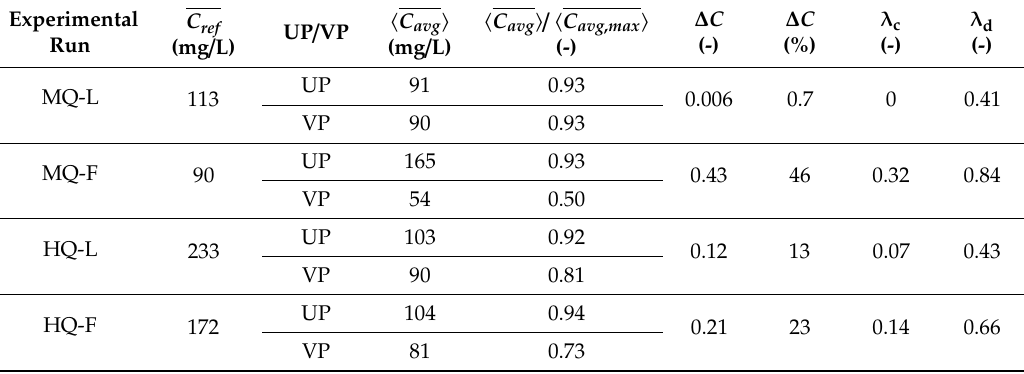
Table 2. Reference concentration C ref , and laterally averaged concentration, (cid:104) C avg (cid:105) , for the unvegetated (UP) and vegetated part (VP) of the channel; the relative, laterally averaged concentration in the UP and VP were normalized with the maximum concentration (cid:104) C avg , max (cid:105) , the relative concentration di ff erence ∆ C ( C ff erential concentration λ / [ C + C ff erential λ c ([ C UP - C VP ] d UP - C VP ), the di UP VP ]), and drag di ([ C D aH - C f ] / [ C D aH + C f ]) at x / h = 68. MQ = medium flow rate (50 L / s); HQ = high flow rate (83 L /